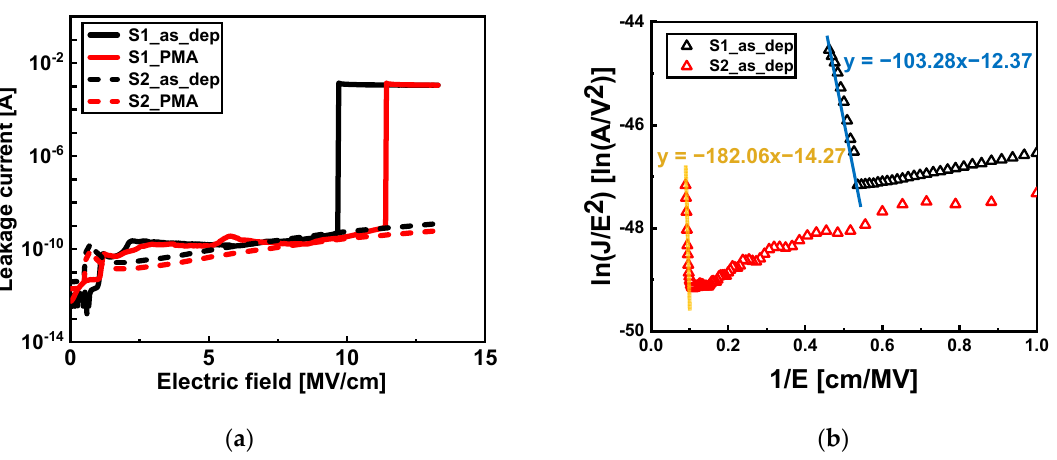
Figure 7. ( a ) Leakage current vs. gate electric field of Al 2 O 3 samples with and without PMA. ( b ) Fowler–Nordheim (FN) plots of I–V curves for as-deposited Al 2 O 3 samples with an O 2 plasma exposure time of 3 (black triangles) and 7 s (red triangles).